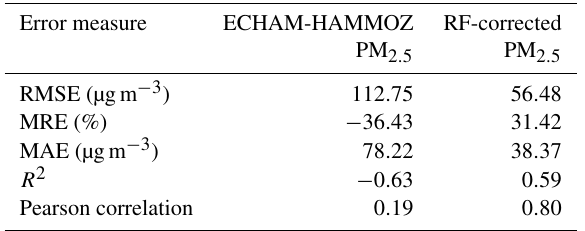
Table 4. The error statistics for the original ECHAM-HAMMOZ PM 2 . 5 and the RF-corrected PM 2 . 5 . Root mean square error (RMSE), mean relative error (MRE), mean absolute error (MAE), R squared ( R 2 ) and Pearson